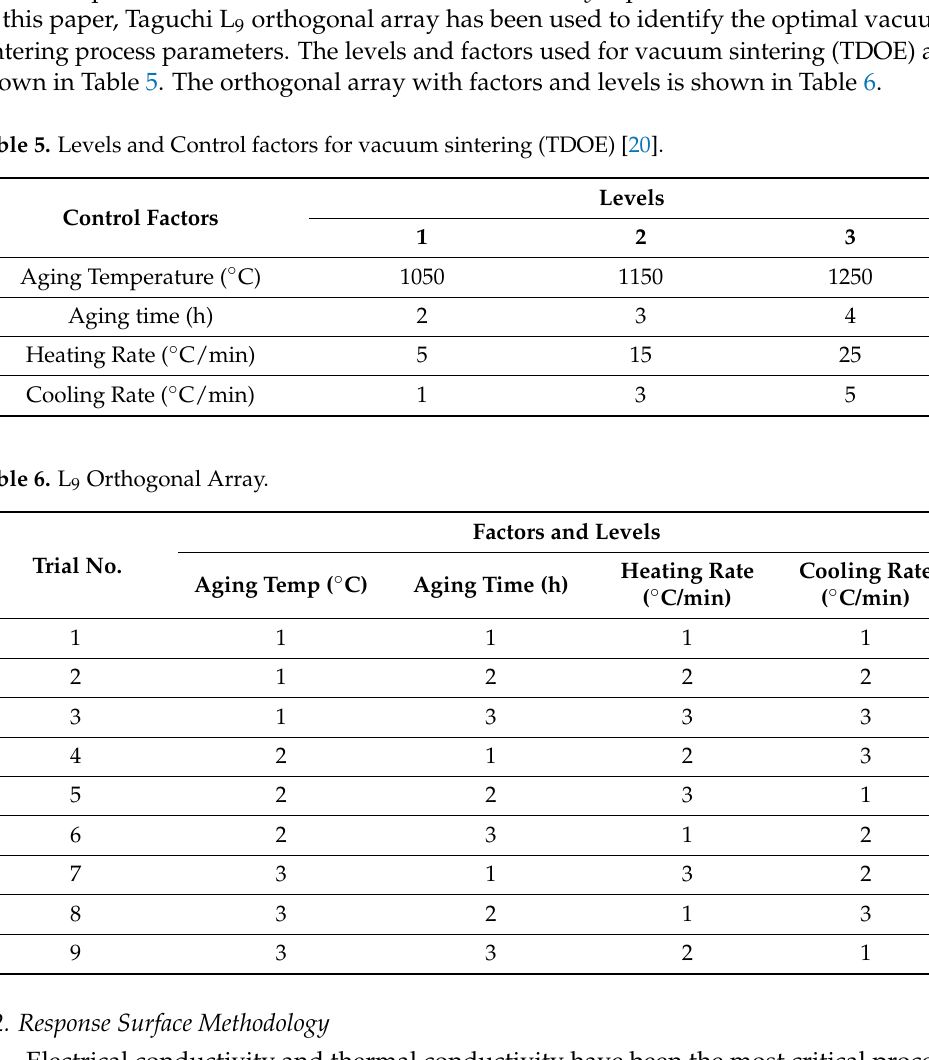
Table 5. Levels and Control factors for vacuum sintering (TDOE) [20].